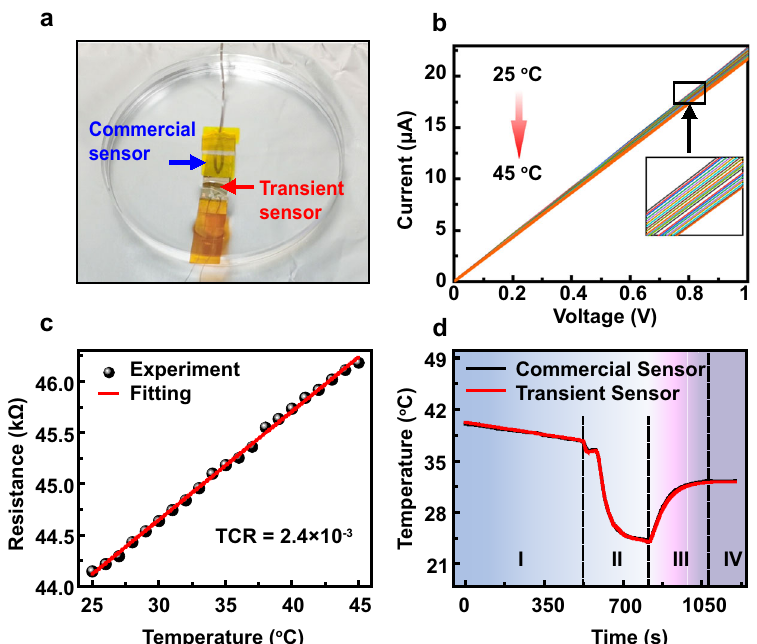
Fig. 5 Evaluations on the temperature response of the fabricated sensor. a In vitro setup for the measurement of biodegradable germanium nanomembrane-based sensor. A commercial temperature sensor is utilized for the calibration. b Current – voltage characteristics of the sensor at different temperatures. The inset is the magni fi ed results highlighted with a black rectangle. c Experimental (symbol) and fi tting (line) results of the changes in resistance of the sensor at different temperatures. d Comparison of the calibrated result obtained from the fabricated biodegradable germanium nanomembrane-based sensor (red curve) to that obtained from a commercial sensor (black curve).